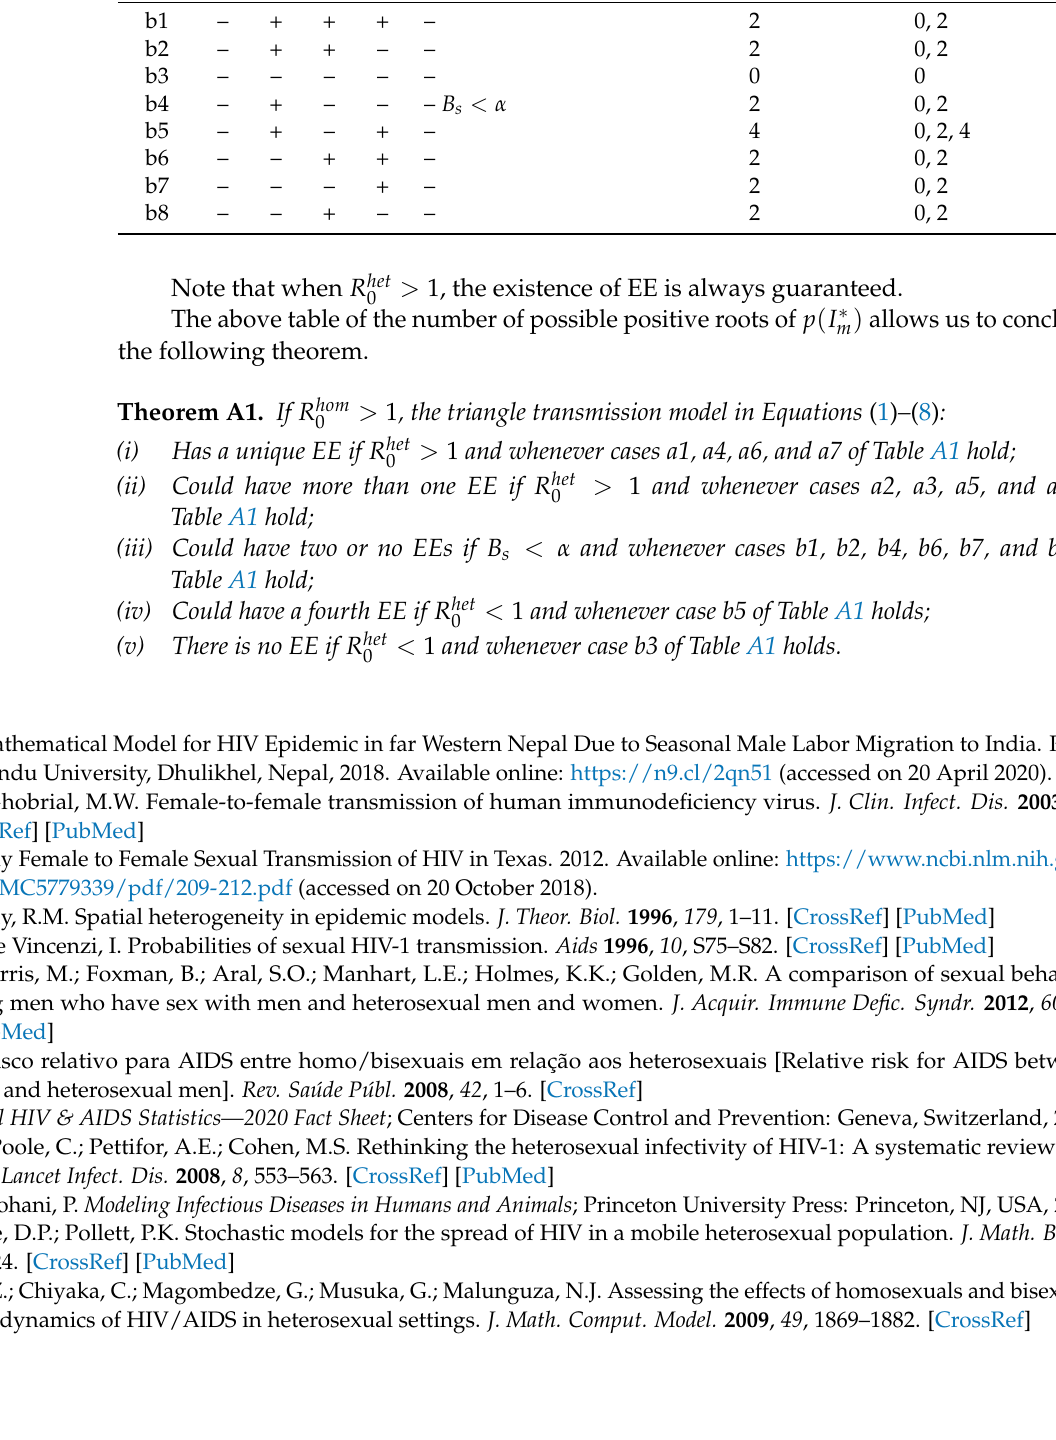
Table A1. Number of possible positive roots of p ( I ∗ m ) . Case a 0